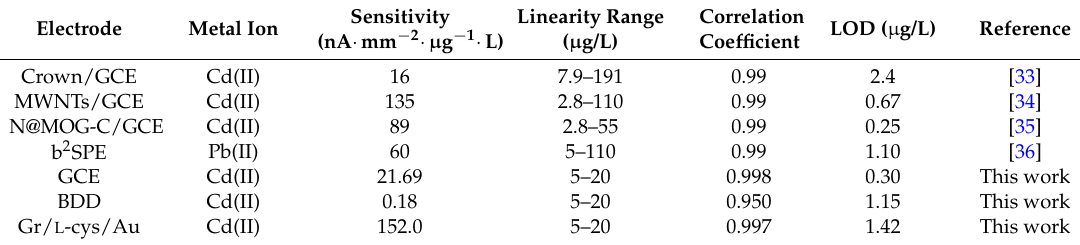
Table 1. Electrode performance for measuring heavy